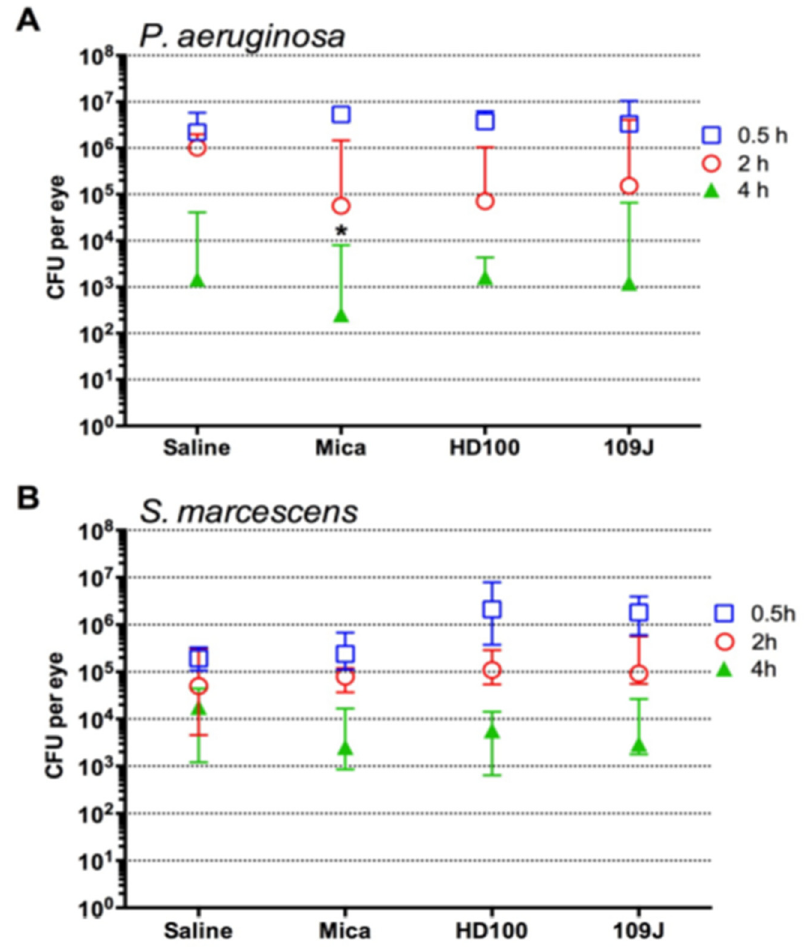
Figure 2. Predatory bacteria impact the ocular surface survival of P. aeruginosa and S. marcescens . ( A , B ). Medians and interquartile ranges of bacterial CFU from ocular surface of New Zealand white rabbits, ( A ). P. aeruginosa , n = 12 eyes per group. ( B ). S. marcescens , n = 8 eyes per group. Asterisks indicate significant differences from saline at the same time point ( p < 0.05) as determined by Mann–Whitney test.